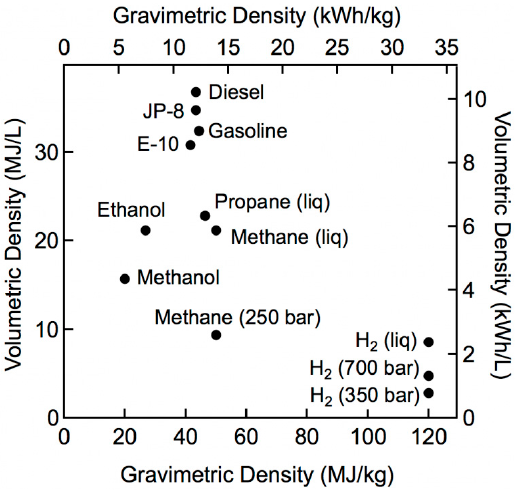
Figure 1. Comparison of specific energy (energy per mass or gravimetric density) and energy density (energy per volume or volumetric density) for several fuels based on lower heating values. After [14].